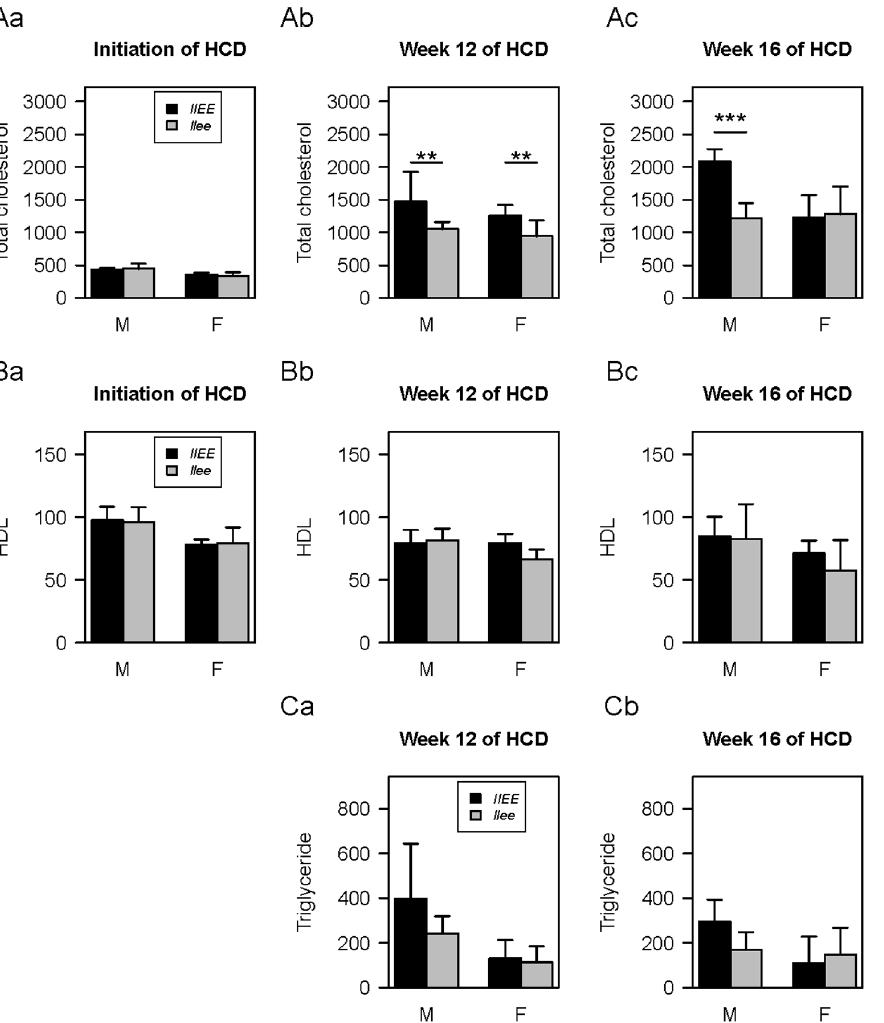
Figure 3. Lipid profile in murine plasma. Total cholesterol ( A ), high density lipoprotein (HDL) ( B ), and triglyceride ( C ) were measured as follows: Aa and Ba initiation of HCD (5 week old mice), N=10 in each group; Ab , Bb and Ca week 12 of HCD, N=6 in each group; Ac , Bc and Cb week 16 of HCD, n=6 in each group. M, male; F, female. Means and SD are shown (mg/dl). * P , 0.05, *** P , 0.01.